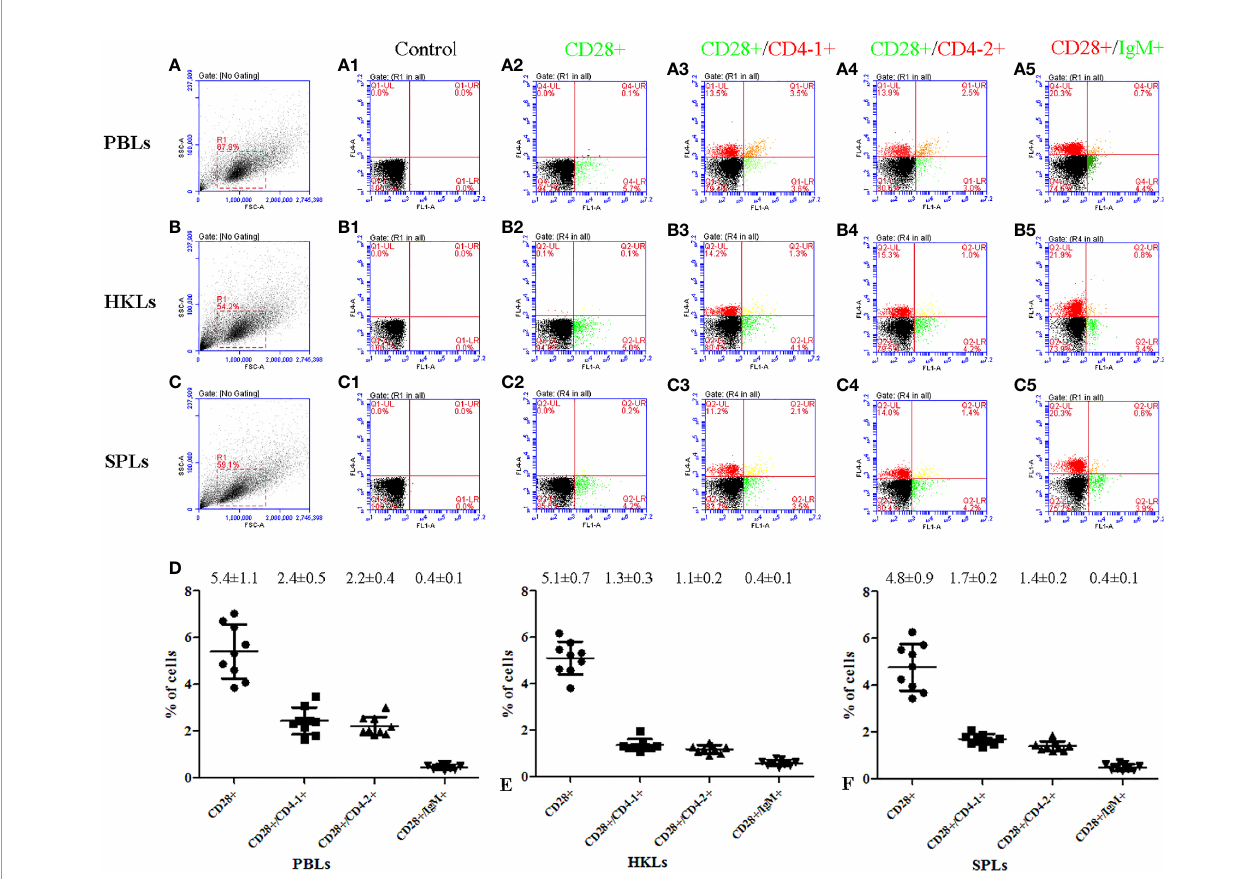
FIGURE 5 | Flow cytometric analysis of CD28 + , CD28 + /CD4-1 + , CD28 + /CD4-2 + , and CD28 + /IgM + leukocytes in peripheral blood, spleen, and head kidney. (A – C) FSC area (FSC-A)/SSC area (SSC-A) analyses and the gate represents leukocytes. (A1 – C1) Negative controls using non-immunized mouse and rabbit serum as primary antibody; (A2 – C5) rabbit anti-CD28 polyclonal antibody and mouse anti-CD4-1, CD4-2, and IgM monoclonal antibody were used as primary antibody; (D) percentages of CD28 + , CD28 + /CD4-1 + , CD28 + /CD4-2 + , and CD28 + /IgM + leukocyte, data represent as mean ± SD, n =